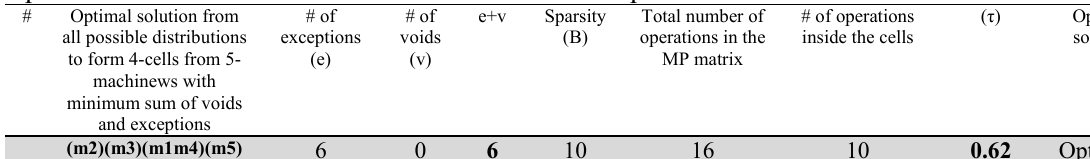
Total number of operations in the